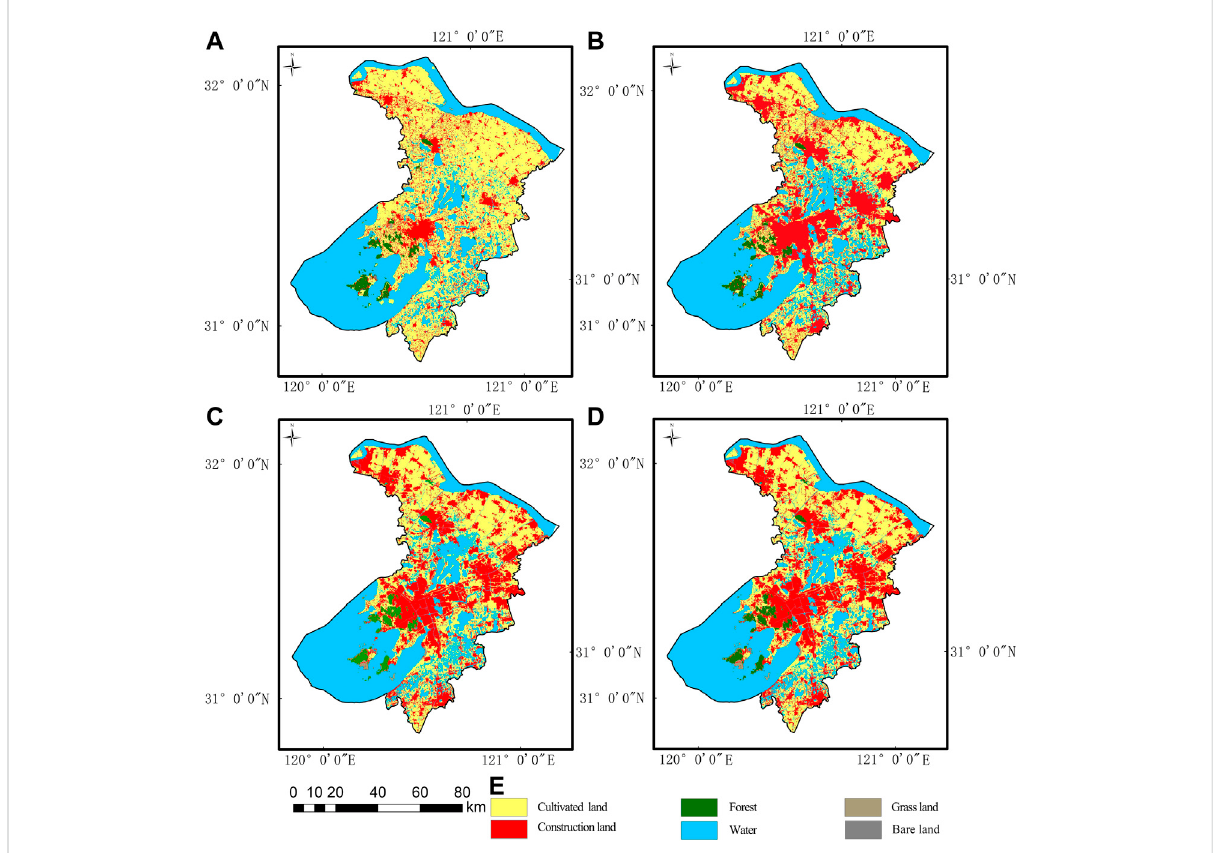
FIGURE 2 Landuse types accordingto theplanningstrategyofSuzhou (A) 2000, (B) 2010, (C) 2020 and (D) spatial distribution simulation oflanduse type in